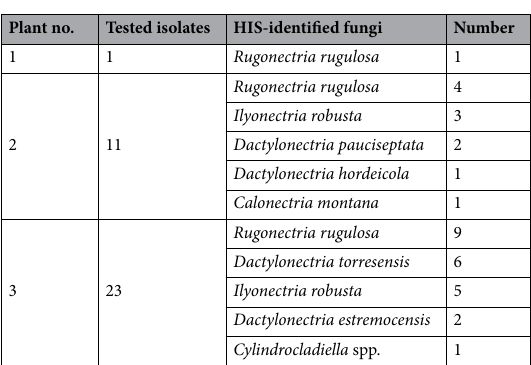
Table 1. Summary of identified fungi by the HIS-gene sequence of selected Nectriaceous isolates gained from replant diseased Rosa corymbifera ‘Laxa’.